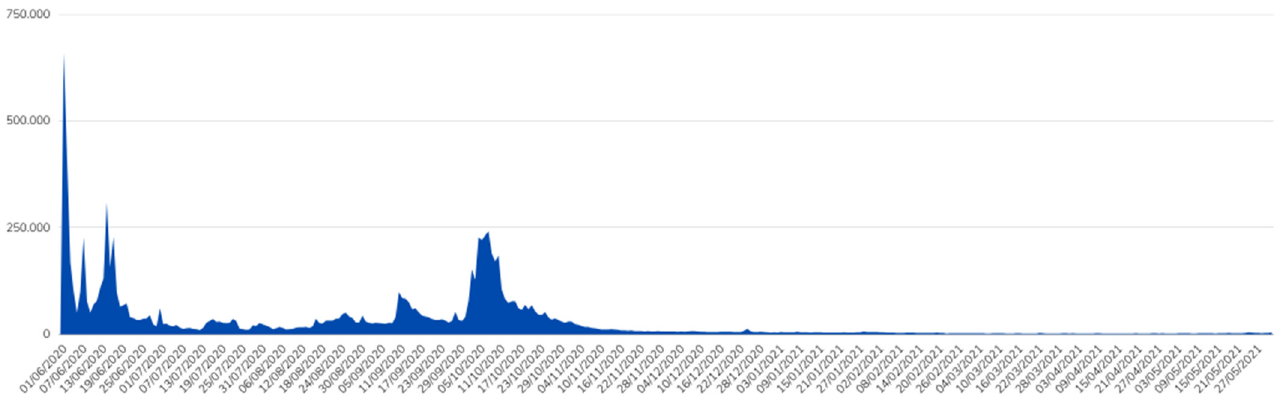
Figure A2. Daily differences in Immuni downloads from its release. Data gathered from Immuni Dashboard Data, Dati andamento, (2021), GitHub repository, https://github.com/immuni-app/immuni-dashboard-data/blob/master/dati/andamento-download.csv (3 June 2021). In the Figure, we can observe two main peaks in time which coincide with the Immuni release period and the Italian COVID-19 second wave.